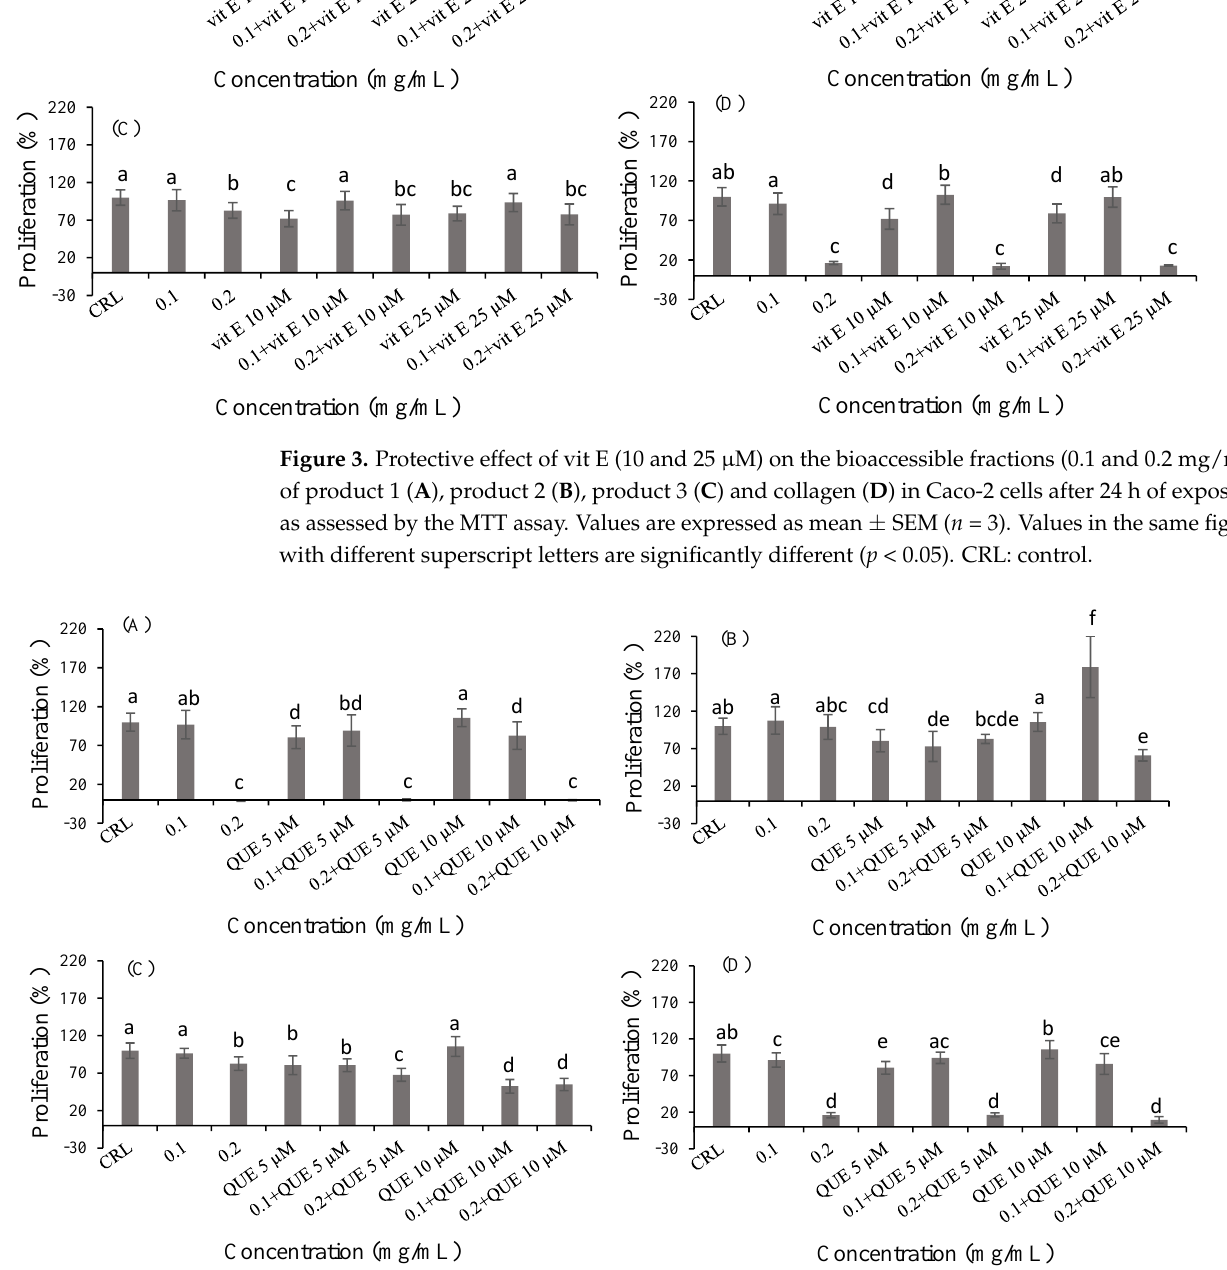
Figure 4. Protective effect of QUE (5 and 10 µM) on the bioaccessible fractions (0.1 and 0.2 mg/mL) of product 1 ( A ), product 2 ( B ), product 3 ( C ) and collagen ( D ) in Caco-2 cells after 24 h of exposure as assessed by the MTT assay. Values are expressed as mean ± SEM ( n = 3). Values in the same figure with different superscript letters are significantly different ( p < 0.05). CRL: control; QUE: quercetin.